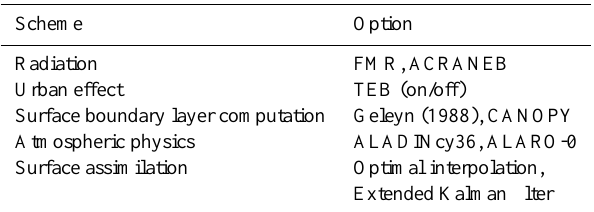
Table 1. Summary of the different model configuration available within the model